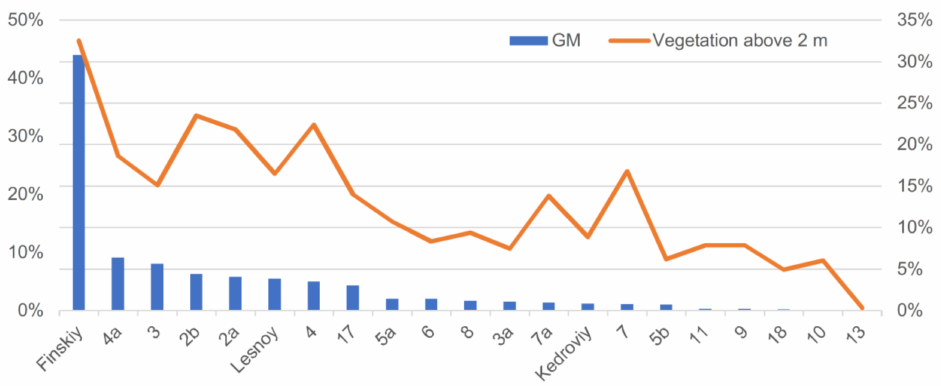
Figure 8. The share of woody vegetation in relation to the value of GM in the microdistricts of